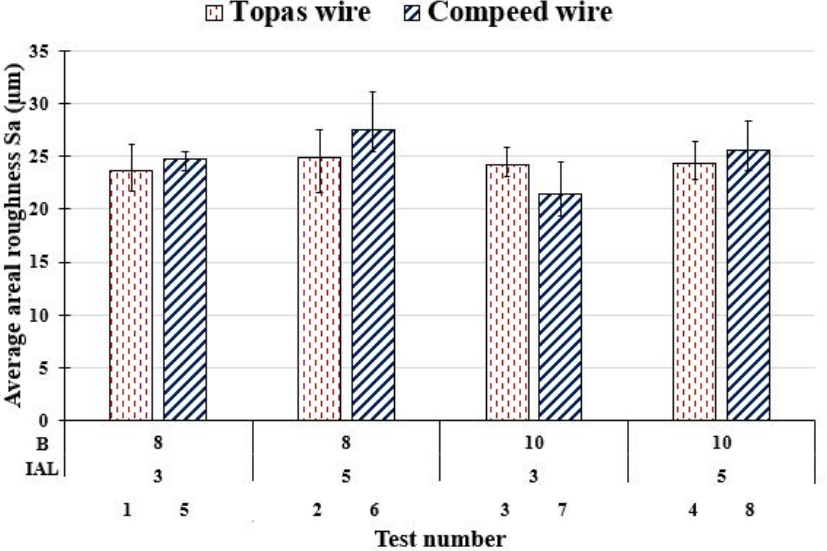
Figure 11. Average areal surface roughness in each test for the Topas and Compeed wire electrodes.